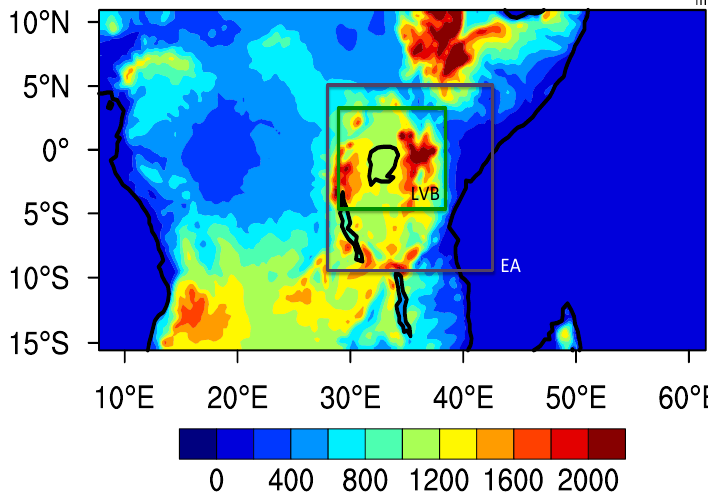
Figure 1. Elevation (m) for the study region and domain utilized in the study. The extent of the East Africa (EA) domain (purple) and Lake Victoria Basin (LVB, green) utilized for the EOF validation analysis are shown by the